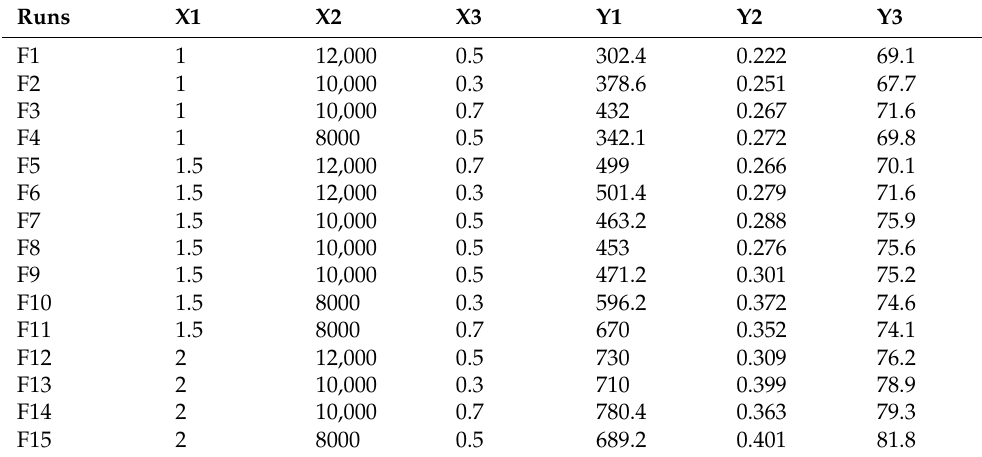
Table 3. Design of experiment for the Box–Behnken method with 15 trial runs having actual